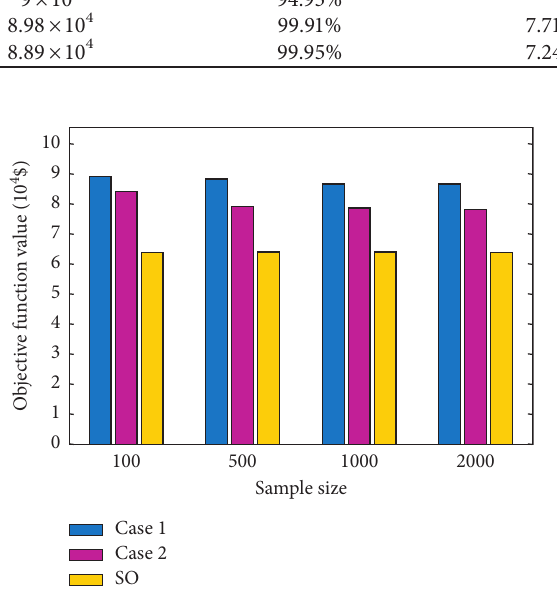
Table 2: Comparison of wind power utilization in two cases under different wind adjusting cost coefficient c wind Adjusting cost coefficient c wind (p.u.) k,t